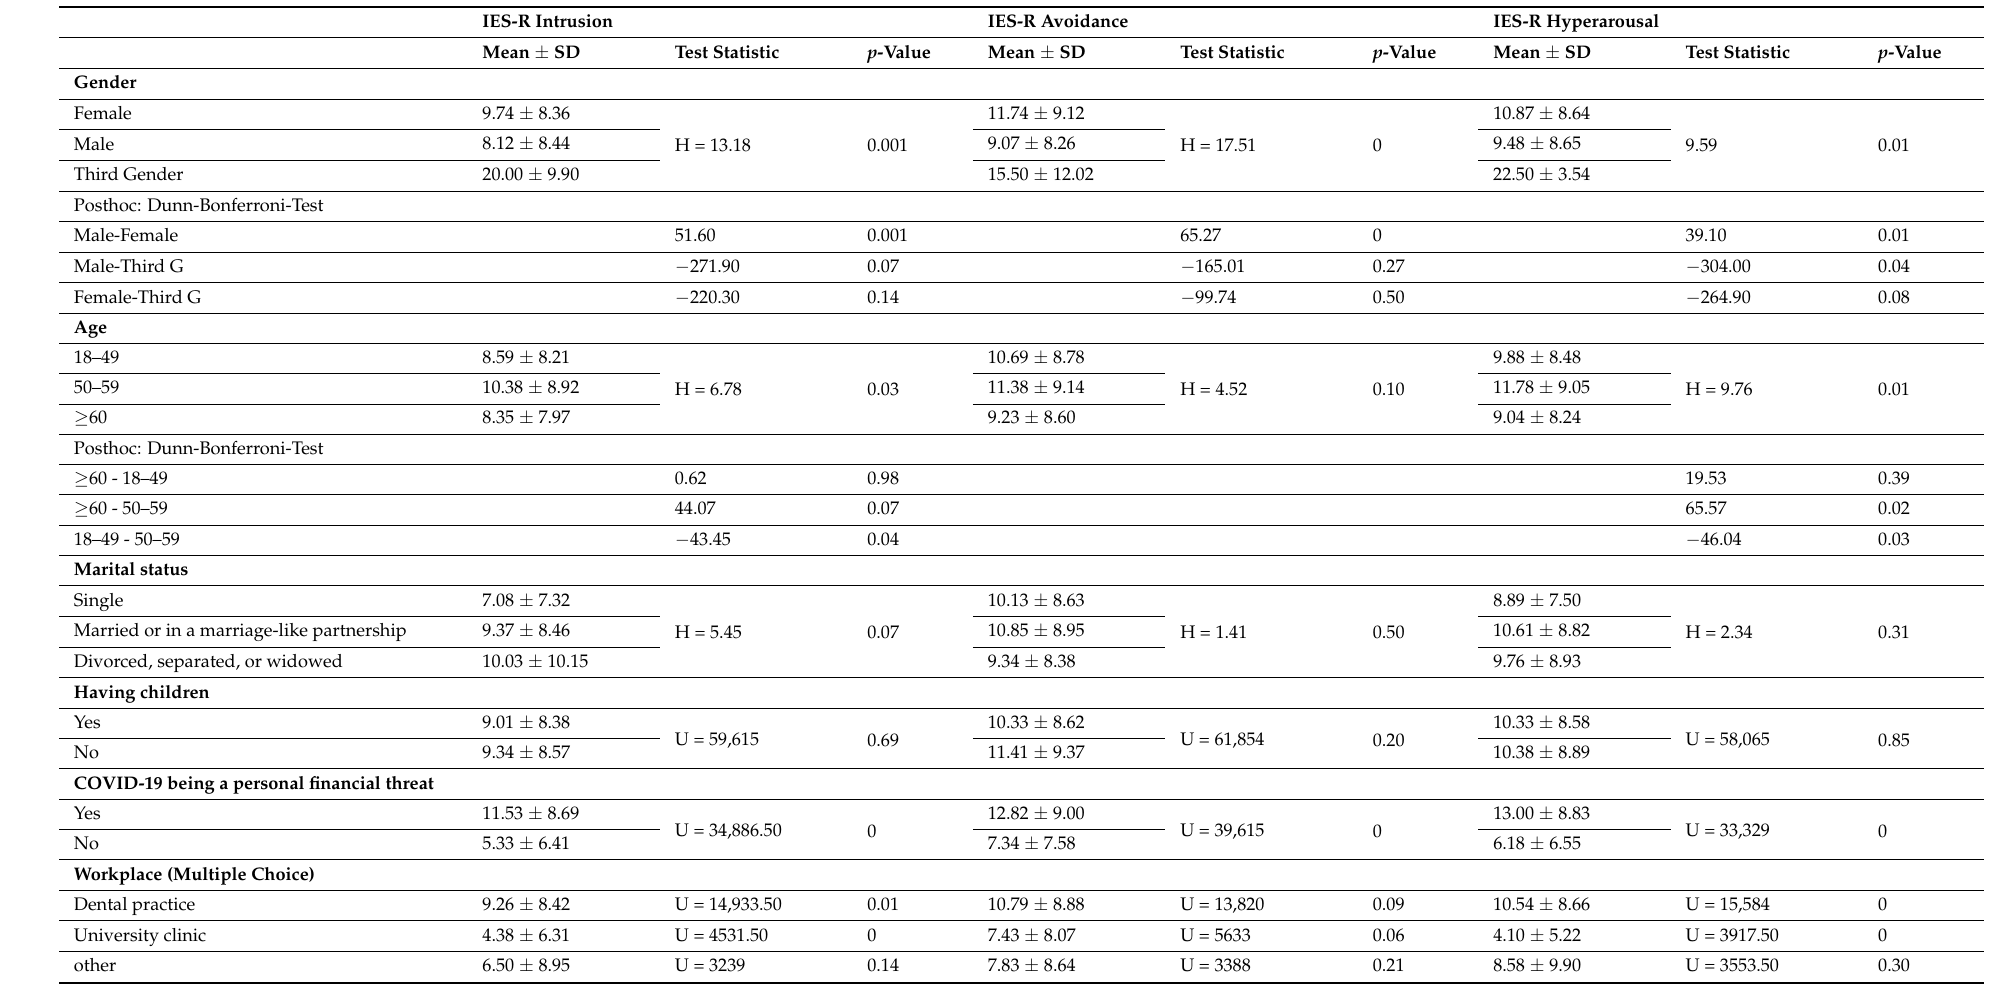
Table 5. Differences between participants characteristics regarding IES-R subscale